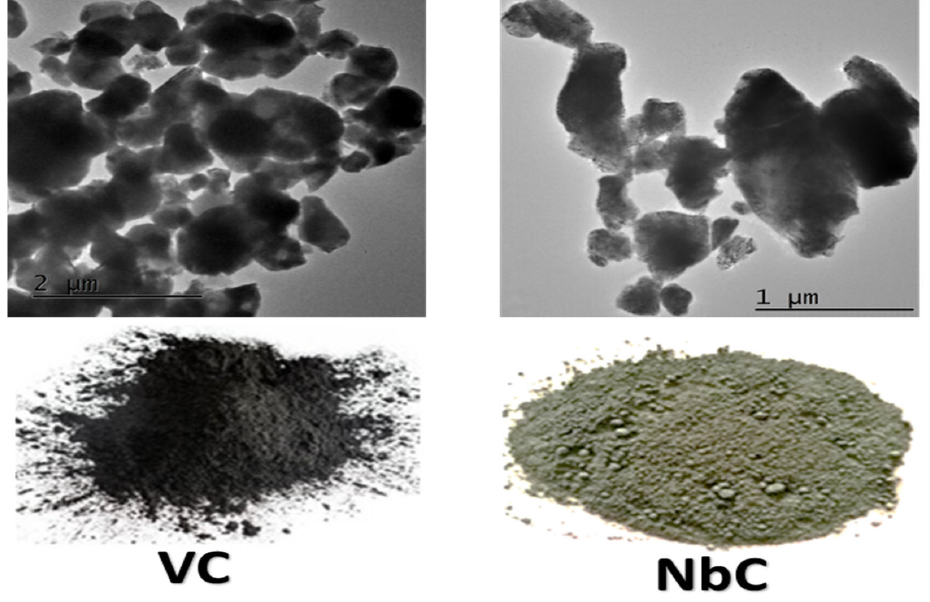
Figure 1. TEM images and corresponding typical powder of the reinforcement particles.